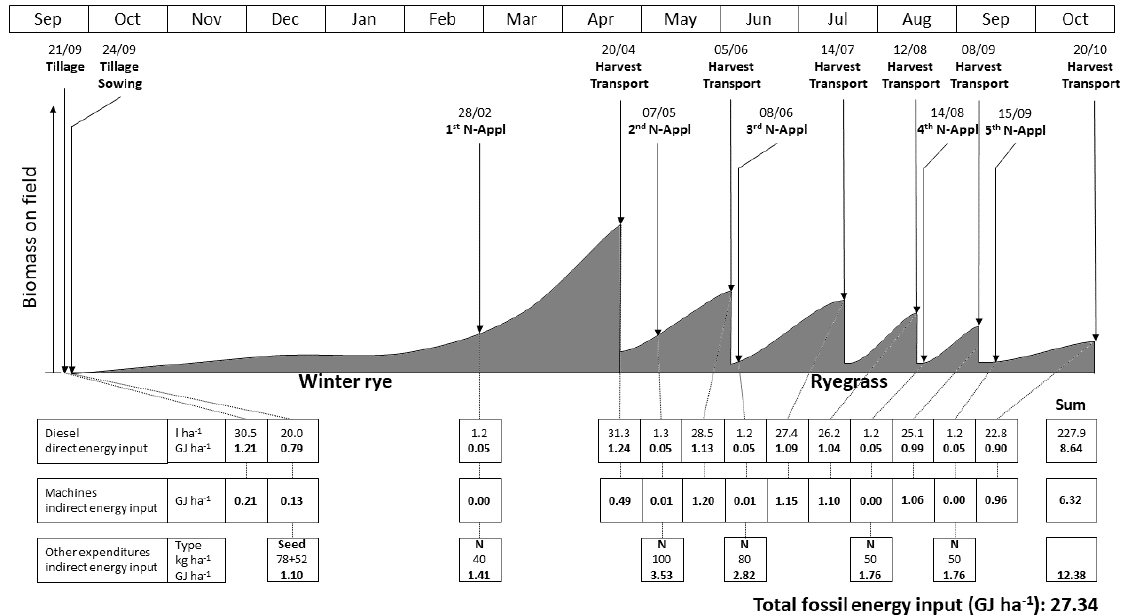
Figure 2. Field operations, resource expenditures, and affiliated energy inputs across the growing season of winter rye and undersown ryegrass. Schematic following [50]. N-Appl: mineral nitrogen application.